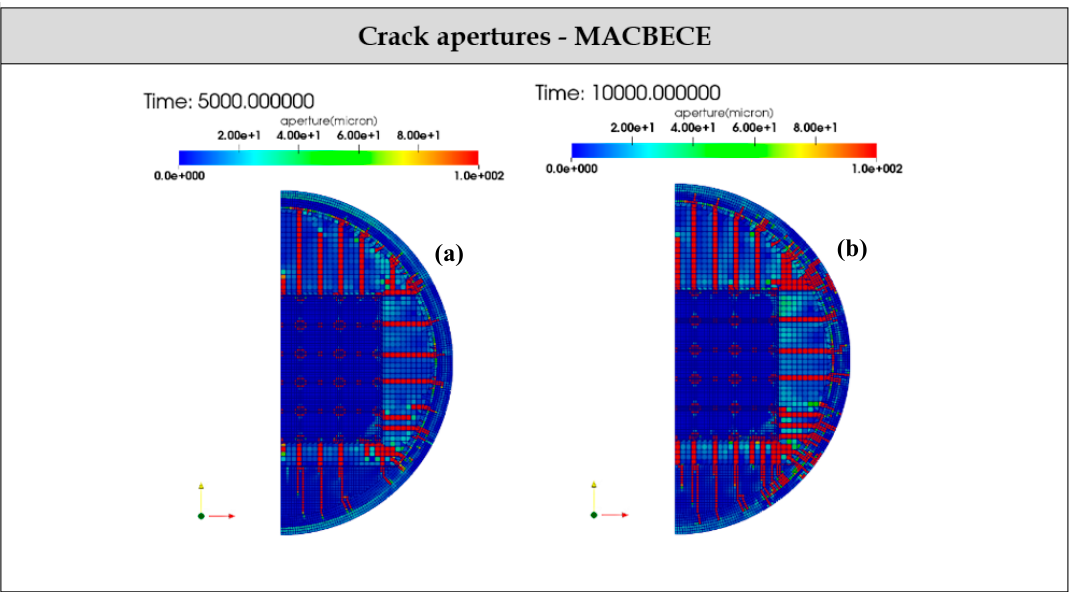
Figure 12. Distributions of crack apertures obtained with MACBECE with a maximum plotted aperture of 0.1 mm at 5000 years ( a ) and 10,000 years ( b ). Cracks with apertures larger than 0.1 mm appear to penetrate the backfill by 10,000 years.